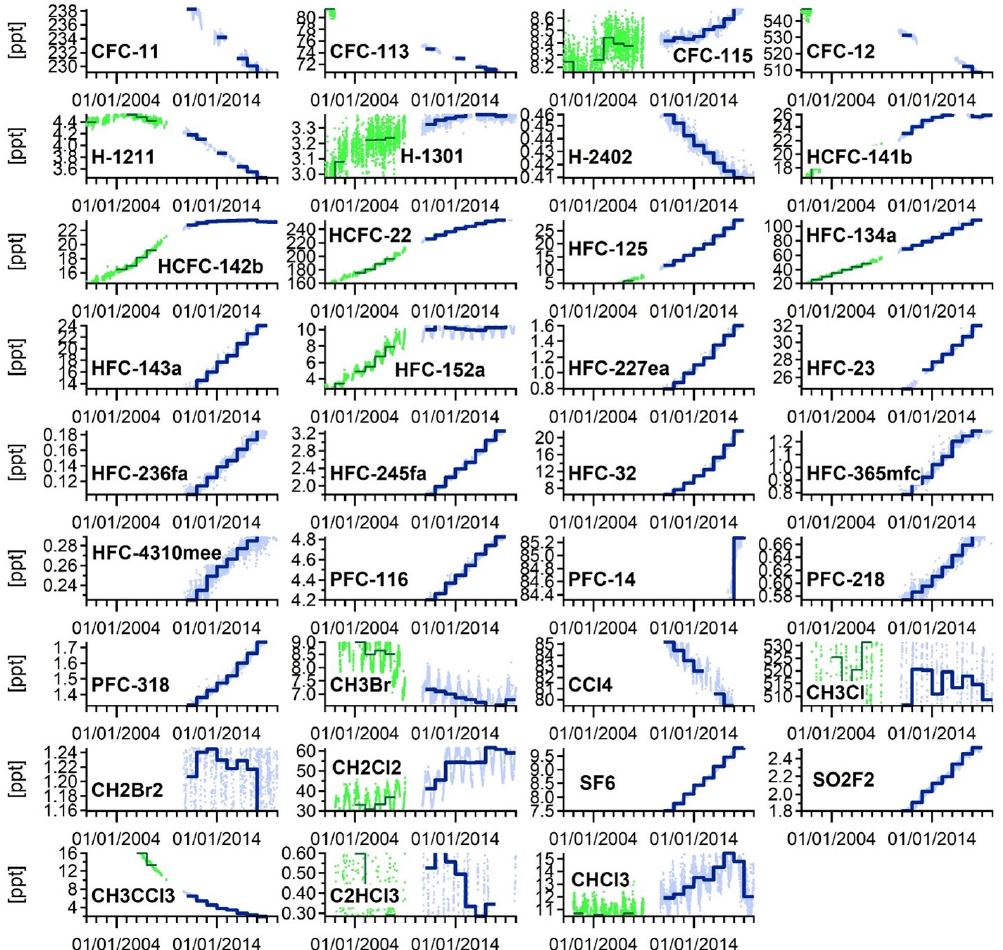
Figure 13. Daily (dots) and yearly (solid lines) mean halogenated compounds measured at the Zeppelin Observatory with the online adsorption–desorption system gas chromatography with mass spectrometry with a flame ionization detector (ADS-GCMS-FID, green, 2001– 2011) and the Medusa GCMS instrument (blue, for 2010 to 2019). Note the higher variability for the ADS-GCMS (many compounds in- cluding CFCs did not meet AGAGE precision requirements; see Sect. 4.3). Daily and annual means calculated only where data coverage is ≥ 75% of the total day or year, respectively. See also Table 6 for information on chemical formulas and compound